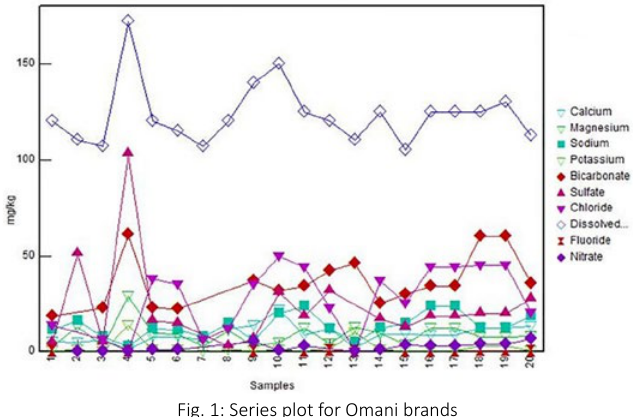
Fig. 1: Series plot for Omani brands